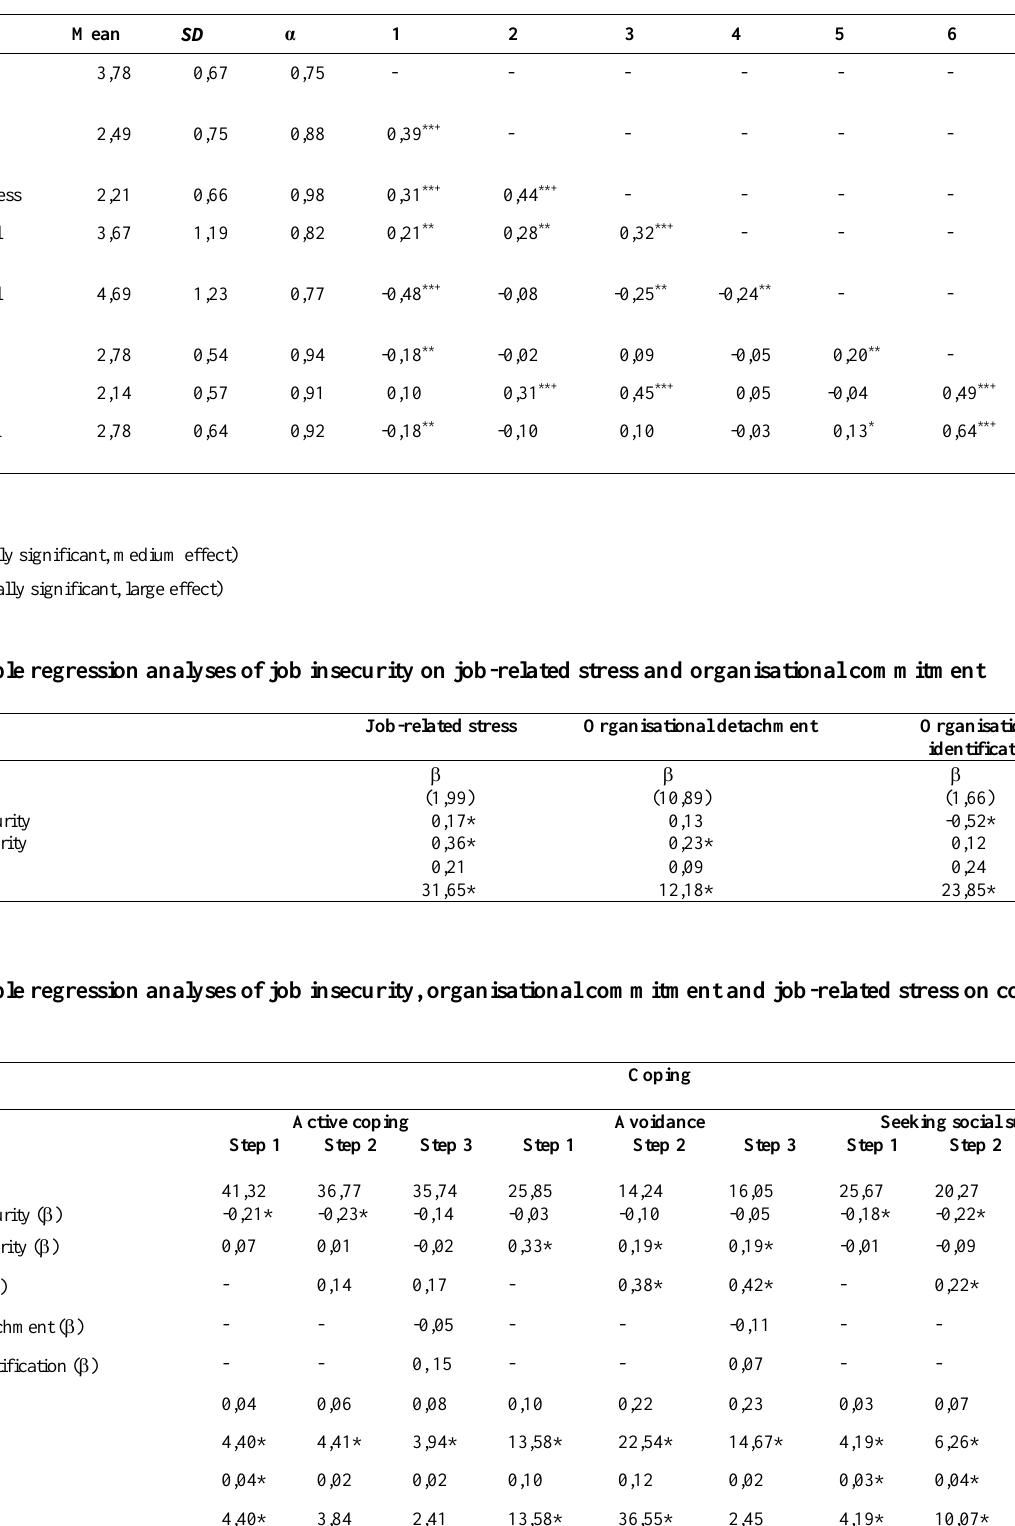
Table 2: Descriptive statistics and reliability coefficients of the measuring instruments